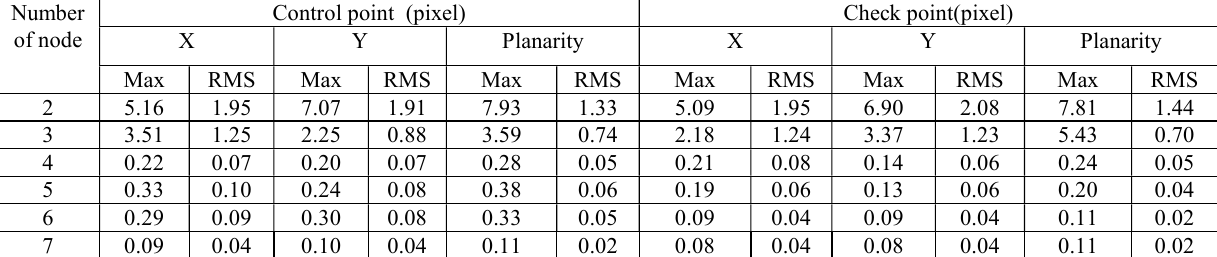
Table 3. BP neural network imagery geometrical model accuracy of dataset 2